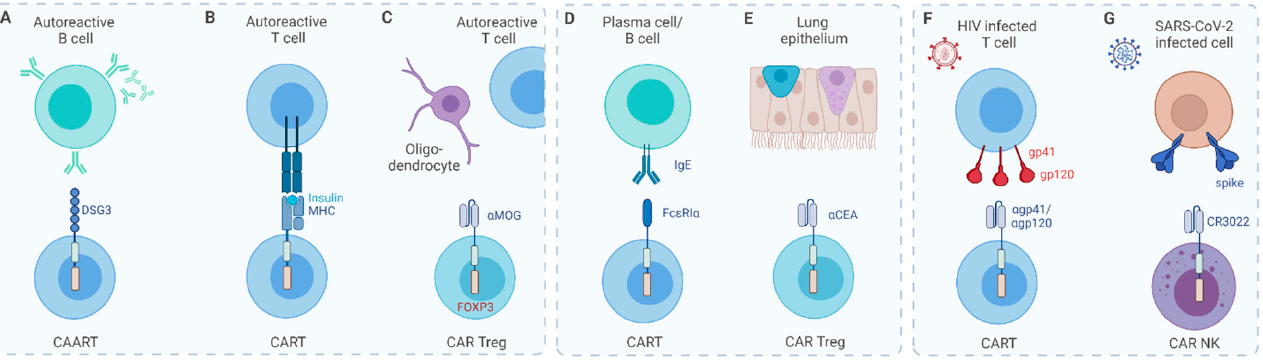
Figure 5. Applications of CAR T cell therapy beyond oncology: DSG3: Desmoglein 3; CAART: chimeric autoantibody receptor T cell; MOG: myelin oligodendrocyte glycoprotein. ( A ) Autoreactive B cell, ( B ) Autoreactive T cell, ( C ) Autoreactive T cell, ( D ) Plasma cell/B cell, ( E ) Lung epithelium, ( F ) HIV infected T cell, ( G ) SARS-CoV-2 infected cell.